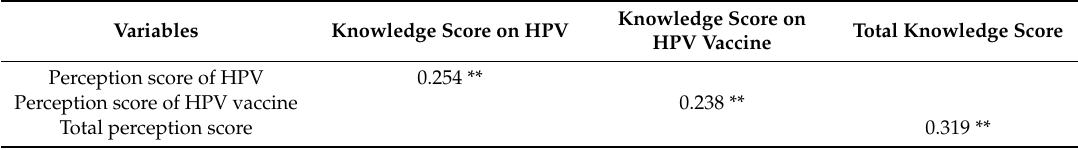
Table 1. Pearson correlation between the knowledge score and the self-reported perception of respondents’ knowledge on human papillomavirus (HPV) and its